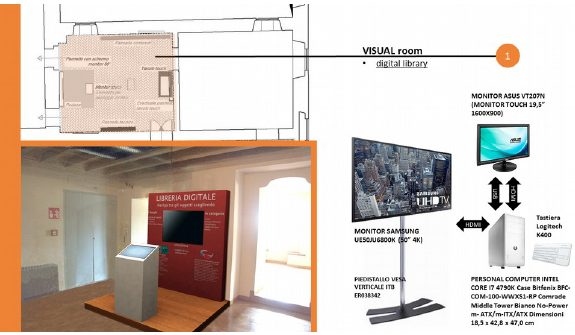
Figure 6. Devices (right) and rendering view of exhibitions for VISUAL room (left).